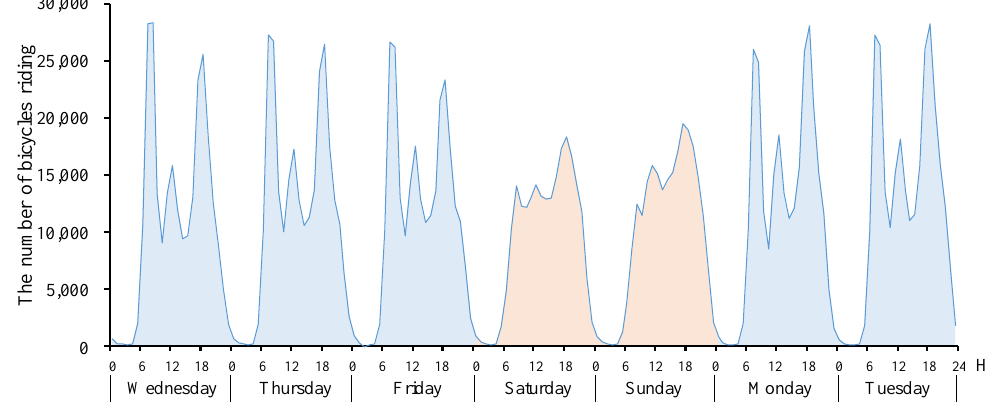
Figure 2. The number of bicycle trips in a week.